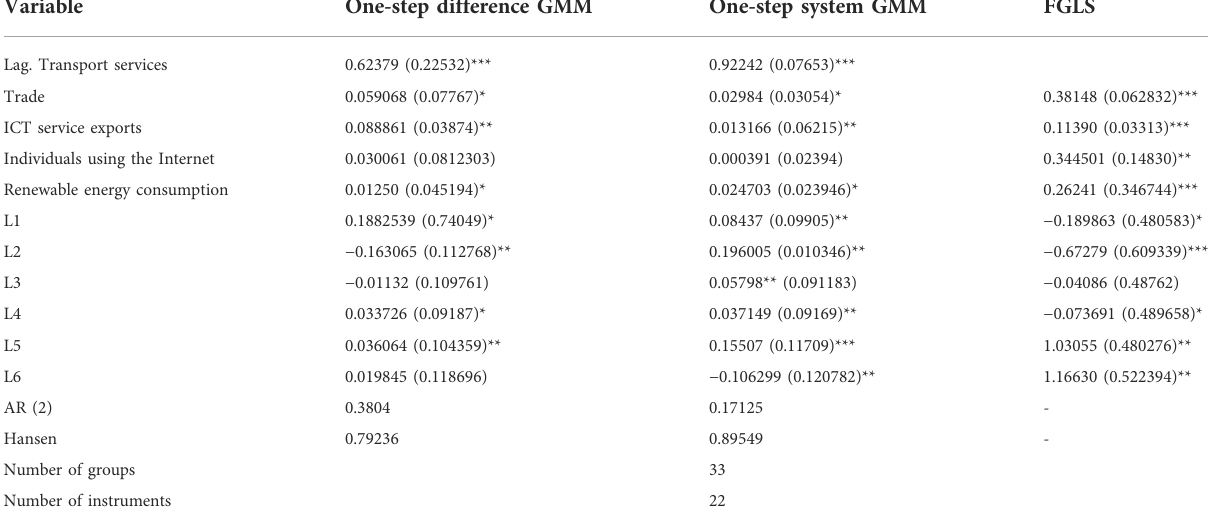
TABLE 4 Dynamic model.